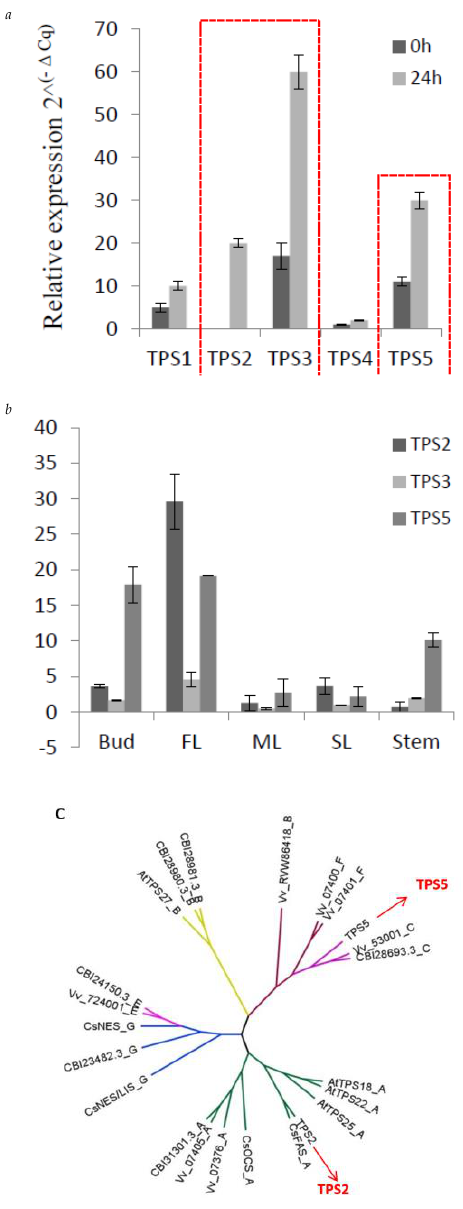
Figure 5. Expression of three TPSs in di ff erent tissues and their response to MeJA. ( a ) q-PCR results of the expression level of TPS1-TPS5 responds to MeJA, red line to highlight the changes of TPS2, TPS3 and TPS5 . ( b ) q-PCR showing the di ff erent expression levels of TPS2, 3 and 5 in five tissues, ( c ) the phylogenetic tree of TPS2 and TPS5, which was obtained by using MEGA-7 software with the neighbor-joining method. At, Arabidopsis thaliana ; Vv, Vitis vinifera ; CsAFS, α -farnesene synthase in Camellia sinensis; CsOCS, β -ocimene synthase in Camellia sinensis ; CsNES, nerolidol synthase in Camellia sinensis; CsNES / LIS, nerolidol / linalool synthase in Camellia sinensis.